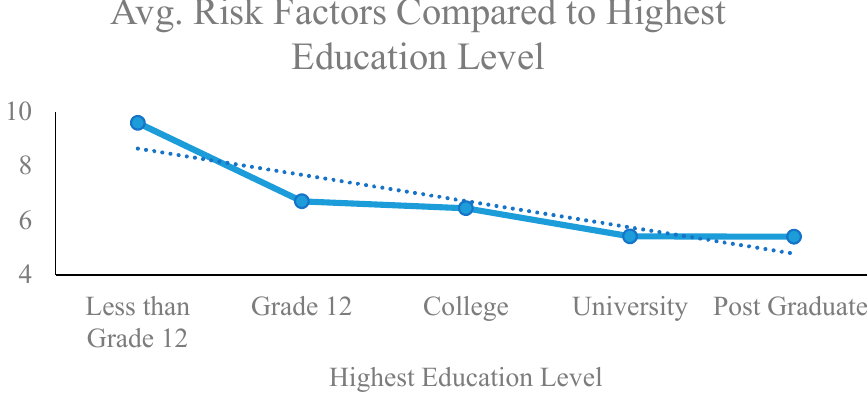
Figure 3. Average risk and adversity factors compared to highest education level. Level of education attained measured on the X-axis and mean number of risk and adversity factors measured on the Y-axis.